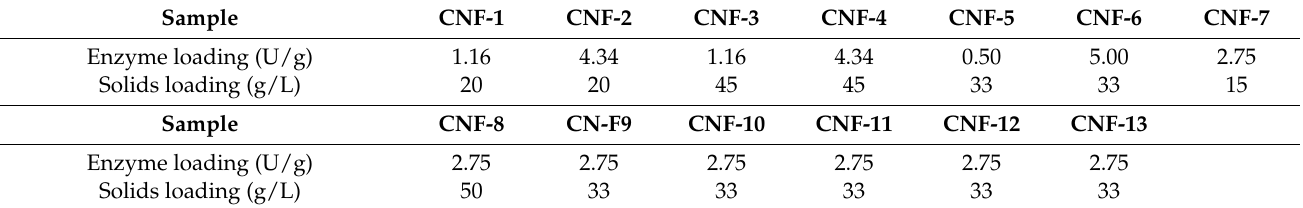
Table 4. Variables and levels used in the central composite rotational design